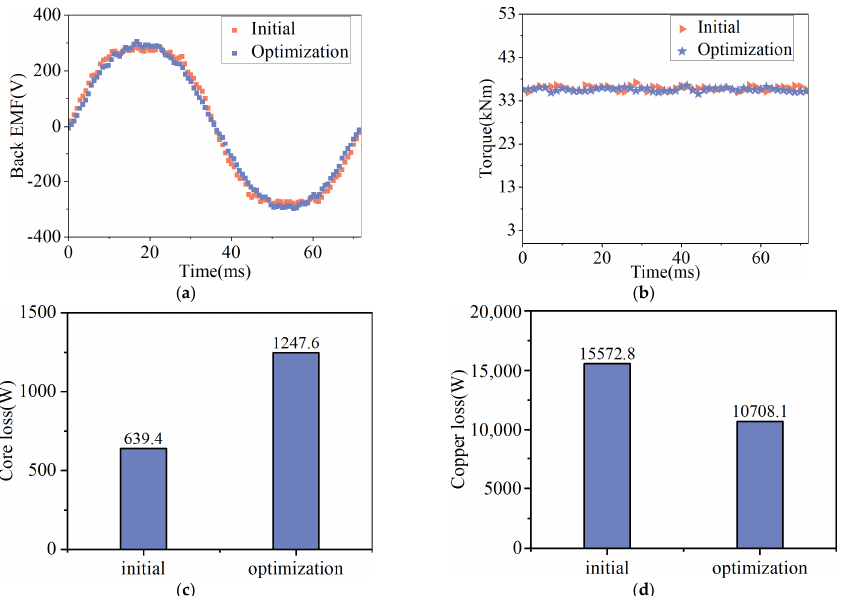
Figure 15. Performance comparison of initial and optimization. ( a ) Comparison of initial and optimized back EMF; ( b ) comparison of initial and optimized torque; ( c ) comparison of initial and optimized core loss; ( d ) comparison of initial and optimized copper loss.